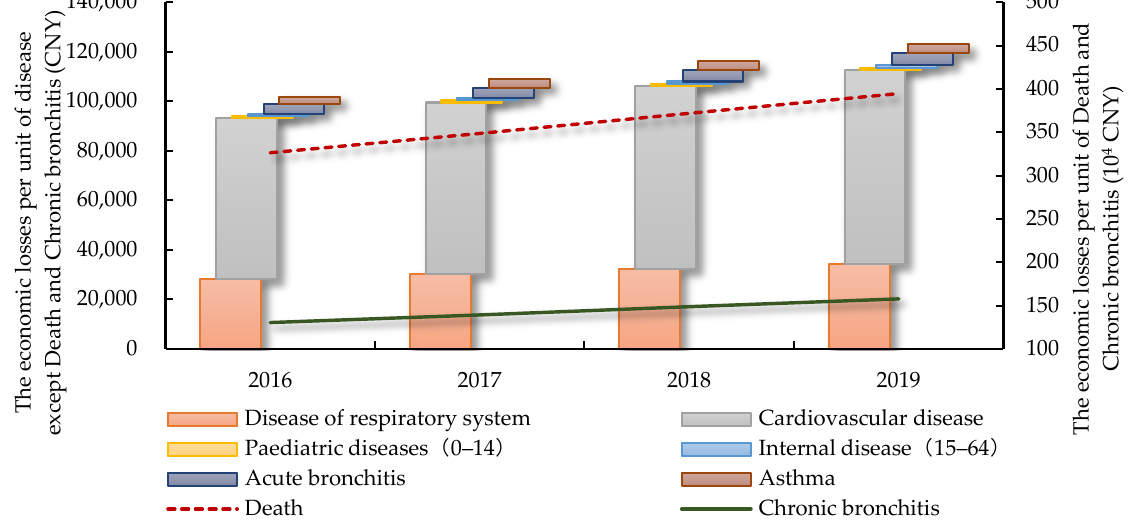
Figure 3. The economic losses per unit of death and various illness in Beijing from 2016 to 2019.